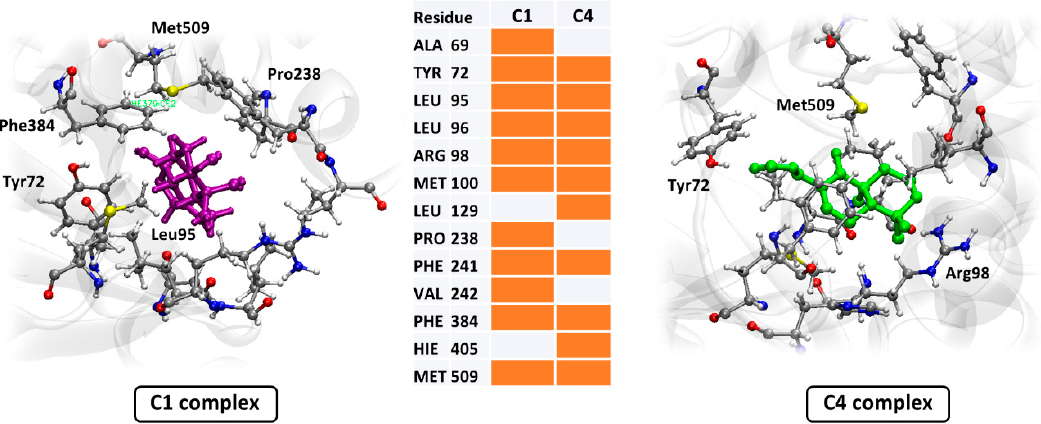
Figure 3. Binding site residues for C1 (purple) and C4 (green) complexes with 14-alpha demethylase predicted from the analysis of the last 50 ns out of 150 ns MD simulations. Common binding site residues are highlighted in the chart.